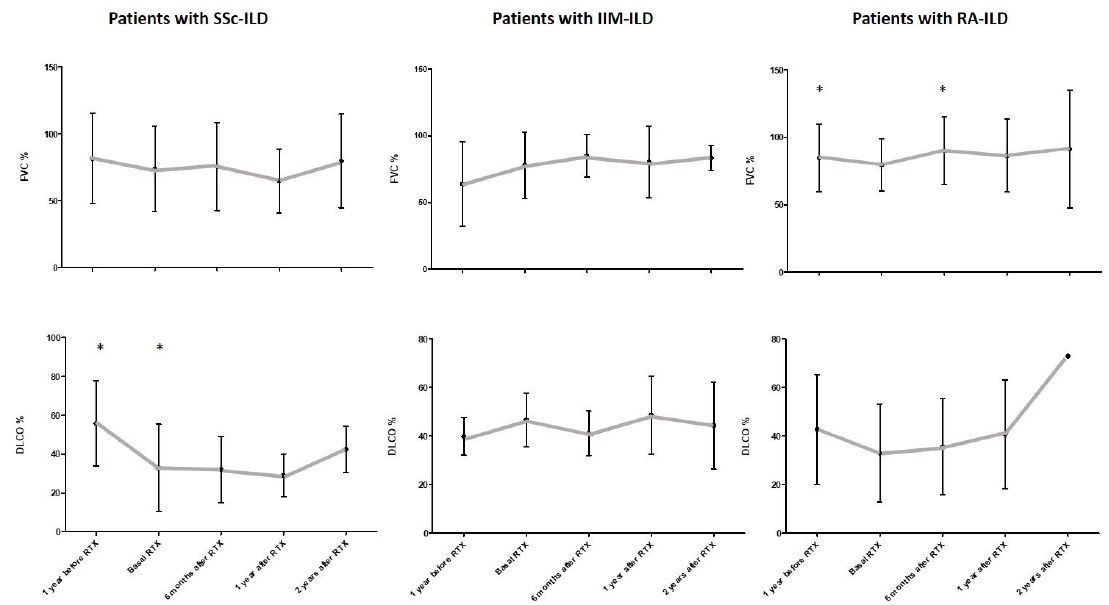
Figure 3. Evolution of FVC and DLCO values in SSc-ILD, IIM-ILD and RA-ILD patients included in this study. Bars indicate mean value and standard deviation for each time point. * indicates statistically significant differences. AD: autoimmune disease; DLCO: diffusing capacity of the lungs for carbon monoxide; FVC: forced vital capacity; IIM: idiopathic inflammatory myositis; ILD: interstitial lung disease; RA, rheumatoid arthritis; RTX, rituximab; SSc, systemic sclerosis.